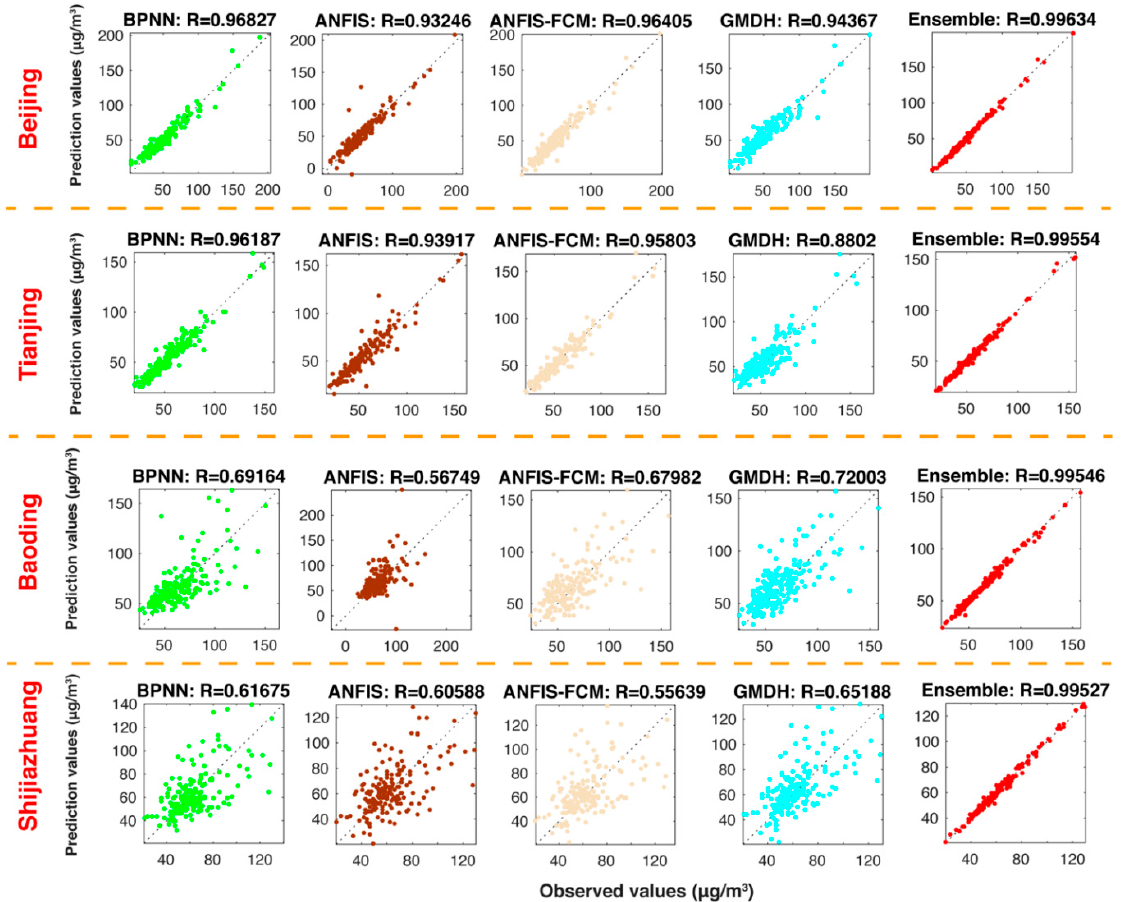
Figure 3. Forecasting results of the ensemble model and individual models.